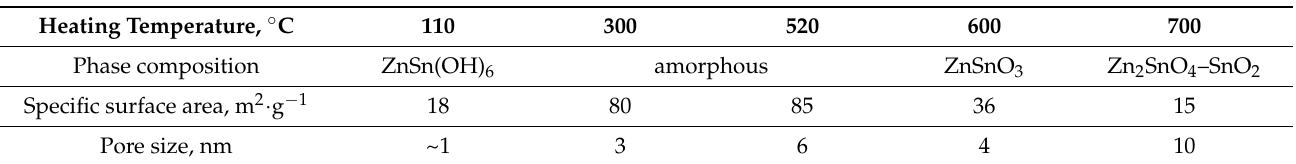
6 and the products of its thermal